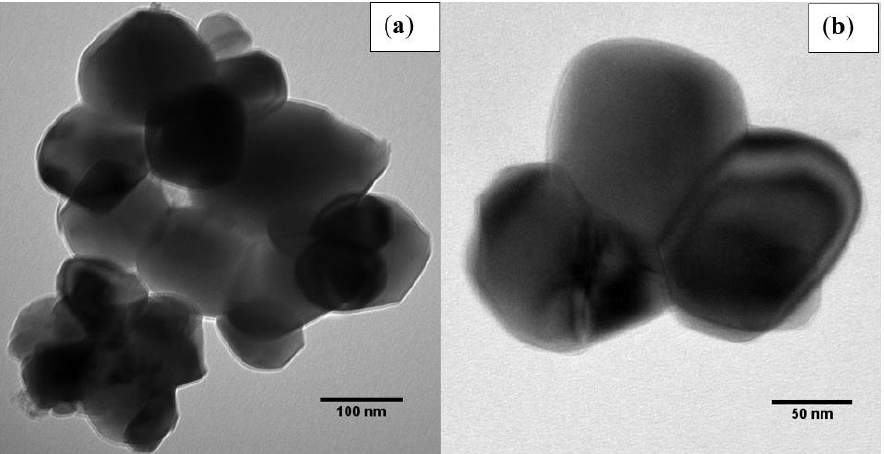
Figure 3. Low (a) and High (b) magnification TEM images of B. ciliate mediated CuO NPs.